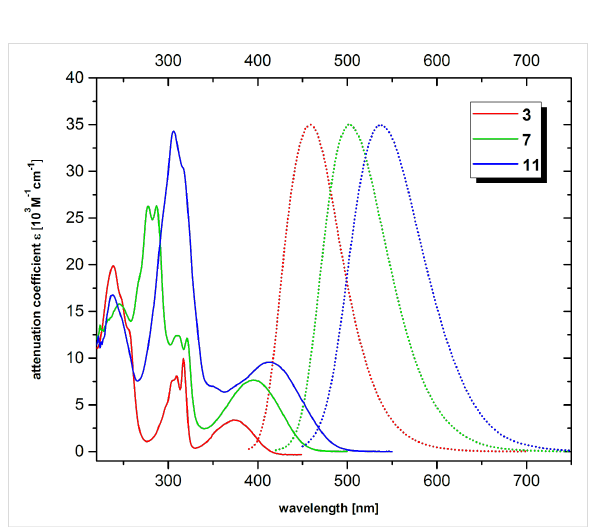
Scheme 3: Synthesis of fatty acid 11c with three olefinic units.